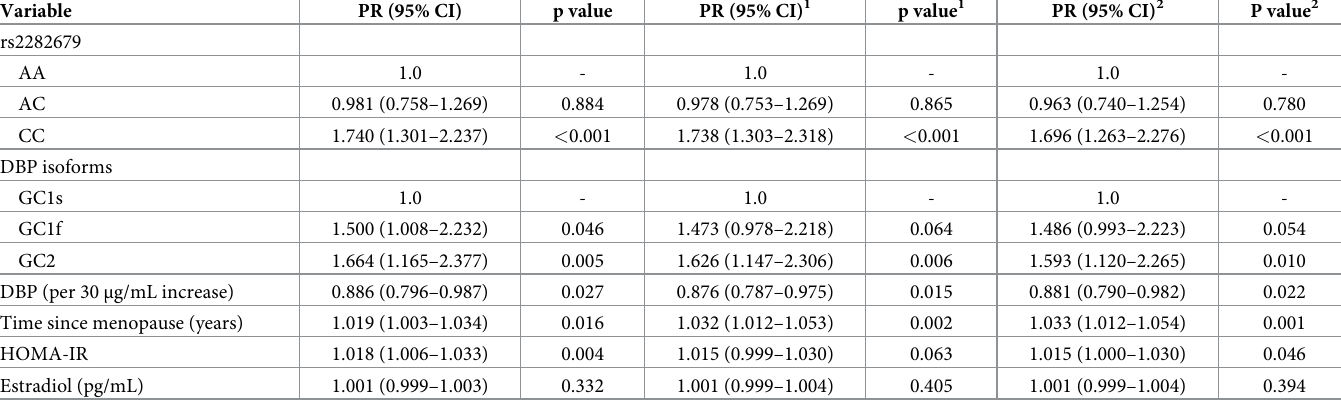
Table 4. Prevalence ratios for 25(OH)D < 20ng/mL according to rs2282679 genotypes, DBP isoforms, DBP levels, time since menopause, HOMA-IR, and estradiol